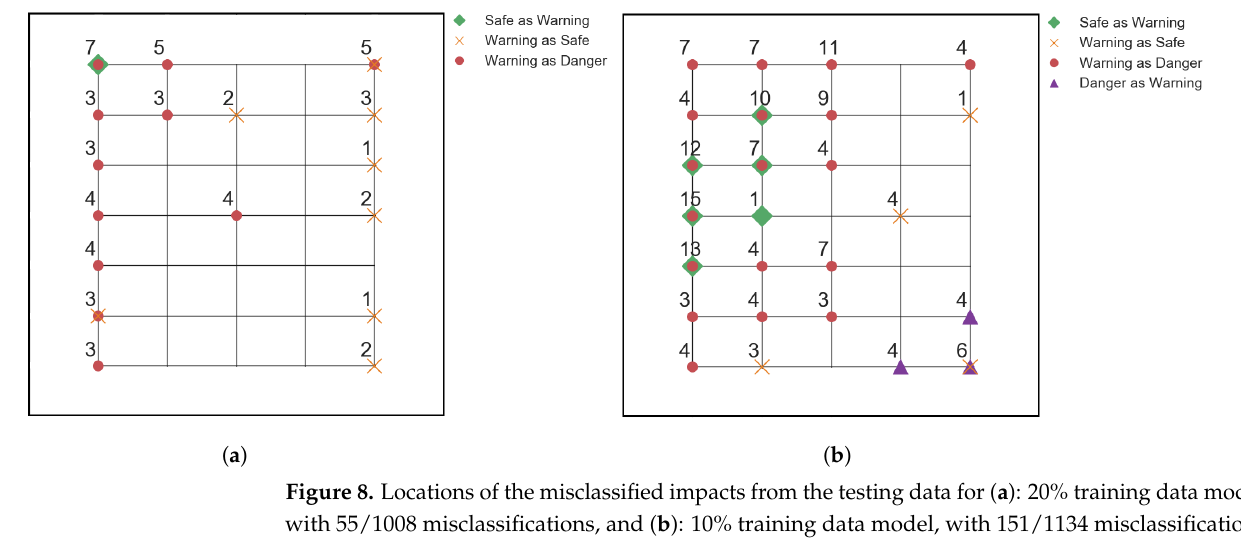
Figure 8. Locations of the misclassified impacts from the testing data for ( a ): 20% training data model, with 55/1008 misclassifications, and ( b ): 10% training data model, with 151/1134 misclassifications. The legends give information of the markers used, and the numbers next to the markers indicate the number of misclassifications on that